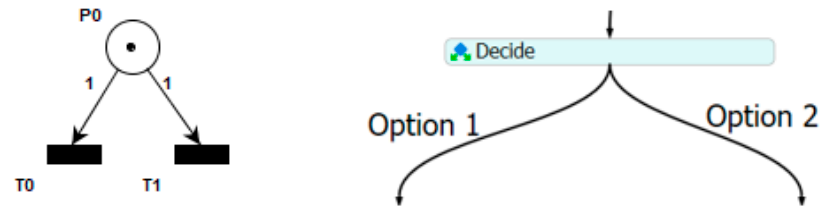
Figure 6. Conflict in Petri net ( left ) and FlexSim ( right ).